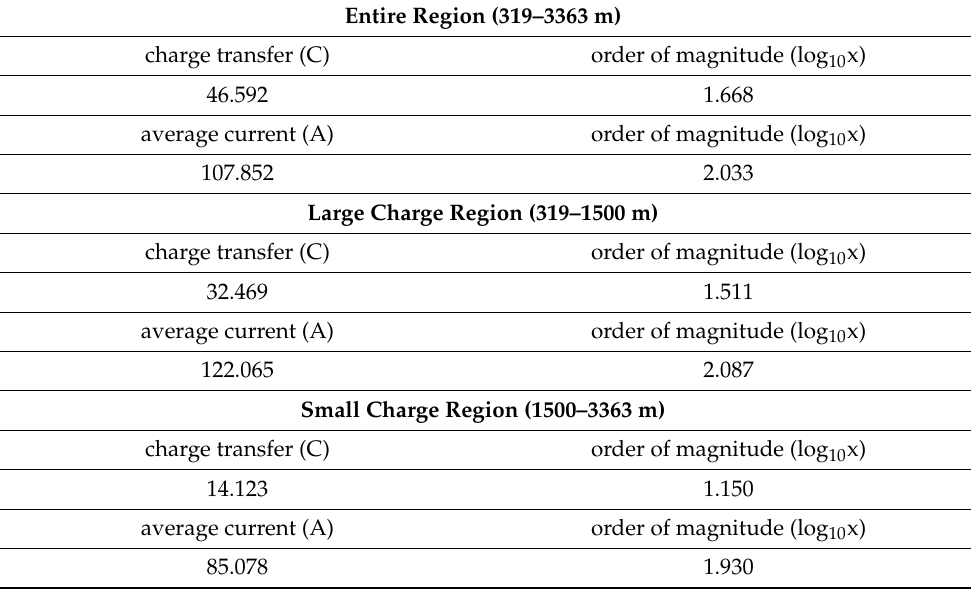
Table 2. The calculated qualitative values of the charge transfer and discharge